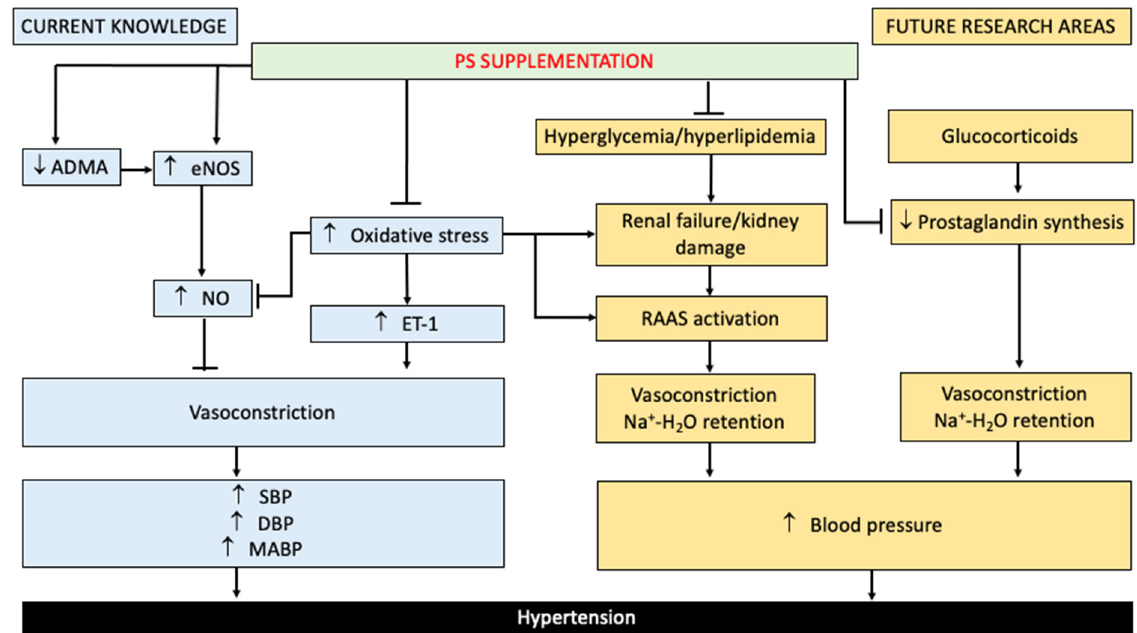
Figure 4. Protective effect of PS supplementation against hypertension: current knowledge and future area of investigation. List of abbreviations: PS, Piper sarmentosum ; ↑ , increase; ↓ , decrease; ADMA, asymmetric dimethyl arginine; NO, nitric oxide; eNOS, endothelial nitric oxide synthase; SBP, systolic blood pressure; DBP, diastolic blood pressure; MABP, mean arterial blood pressure; ET-1, endothelin 1; RAAS, renin-angiotensin-aldosterone system; Na + , sodium ion; H 2 O, water.